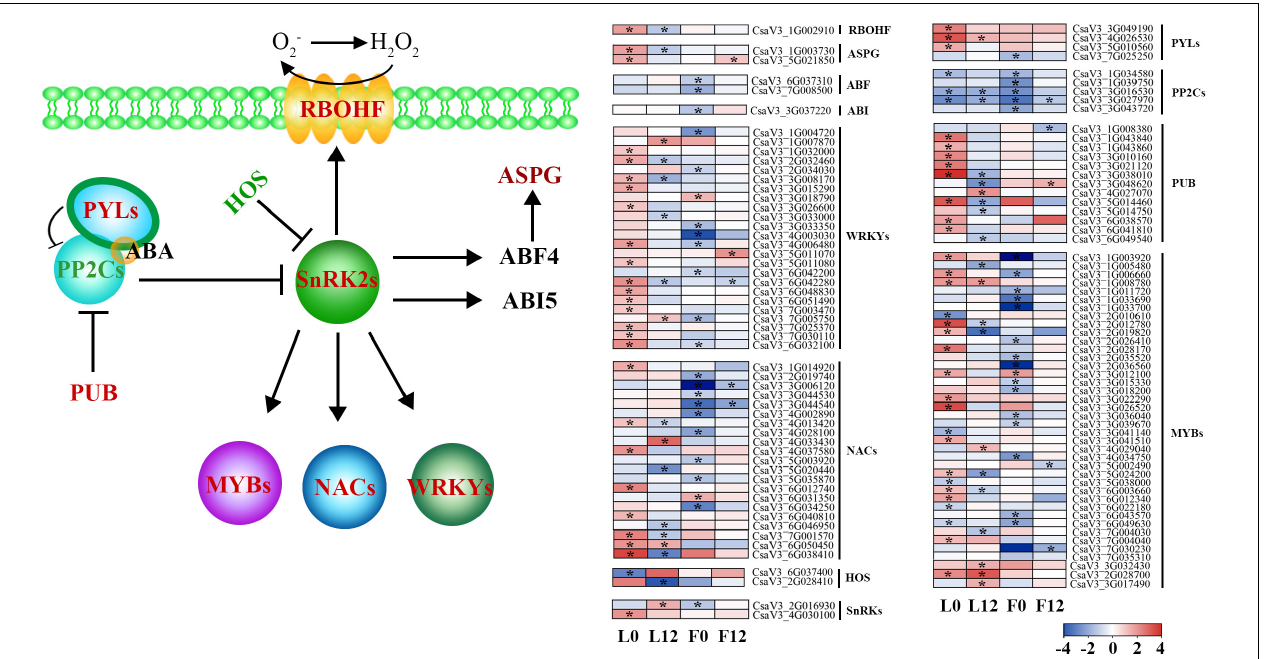
FIGURE 5 | A model for the abscisic acid (ABA)-mediated stress signal transduction after S fumigation. The upregulated and downregulated genes after S fumigation are presented in blue and red boxes, respectively. The white boxes represent genes with unchanged expression. * indicates DEGs with | log2FoldChange| > 1 and P -value < 0.05. HOS, E3-ubiquitin-ligases; SnRK2s, SNF1-related kinases; PP2Cs, protein phosphatase 2Cs; PYLs, PYR-like genes; PUB, U-box type E3 ubiquitin ligases; RBOHF, NADPH oxidases; ASPG, aspartic protease; ABF4, ABA-responsive element binding factor 4; ABI5, ABA insensitive factor 5.